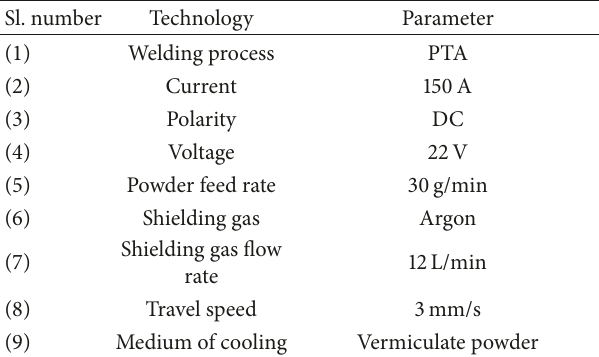
Table 1: Welding parameters maintained in PTA welding